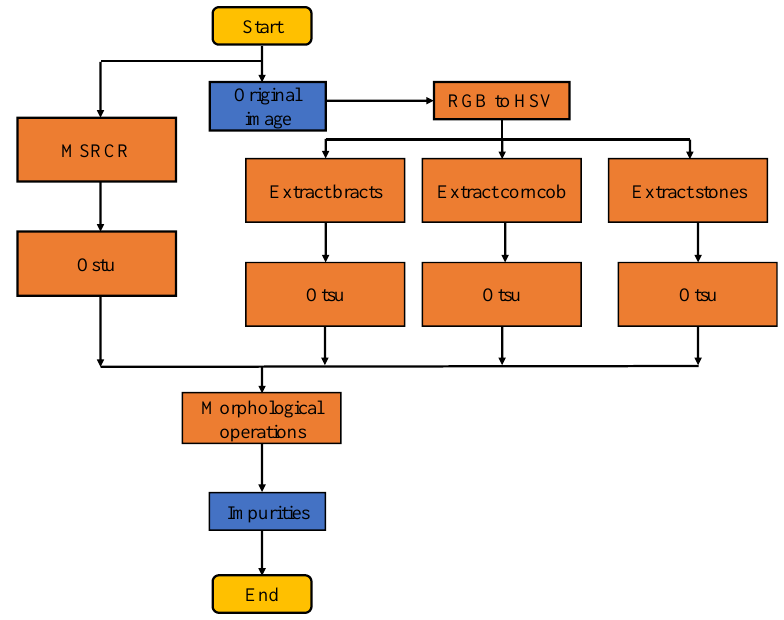
Figure 4. Image processing flow chart.